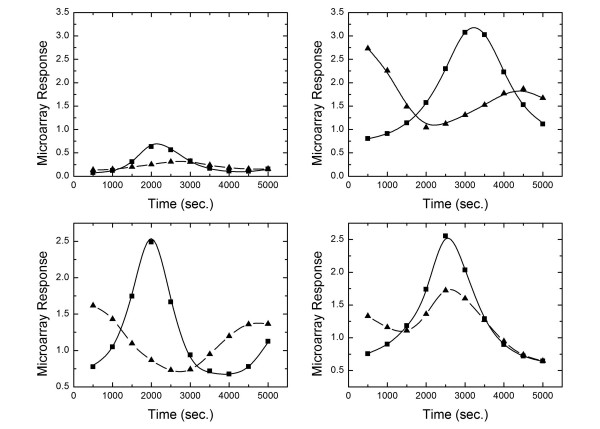
Comparison of observed (solid line) and predicted microarray data for genes 1–4 (see Table 1). Triangles indicate the best microarray fit when there are four mistakes in TRN (the first four entries in the upper left diagonal for genes 1–4); squares indicate the best microarray fit when we allow our program to correct the network. This shows that our algorithm is not only able to calculate the TF time courses, binding constants, etc.; it can also be used as a tool to decide whether a TF is up or down regulating a gene.